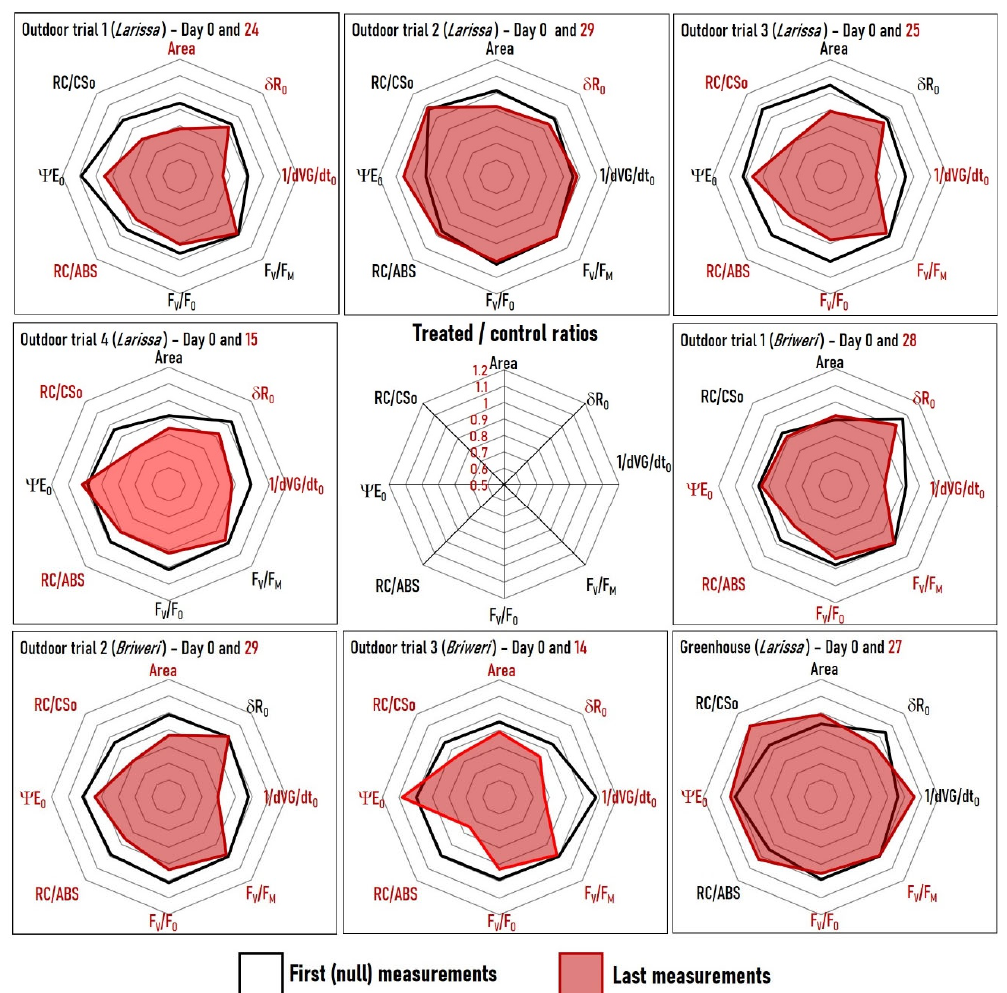
Figure 4. Spider plots depicting the treated/controls ratio at the first (null) and the last measurement time points for the eight OJIP parameters stated earlier. We substituted dVG/dt O with its reciprocal value 1/dVG/dt O so that all parameters correlate positively with photosynthetic efficiency. The plot’s scale is displayed in the center. If a parameter’s label is red, the last measurement revealed a statistically significant difference ( p < 0.05) between RF ‐ EMF ‐ exposed and control plants with relation to that particular parameter.